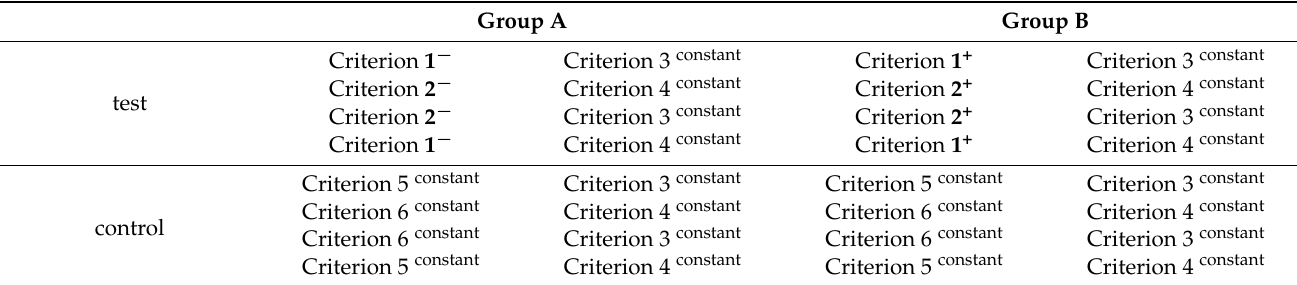
Table 3. The distribution of criteria types across the test and control conditions. Criteria in bold underwent experimen- tal framing. Group A Group